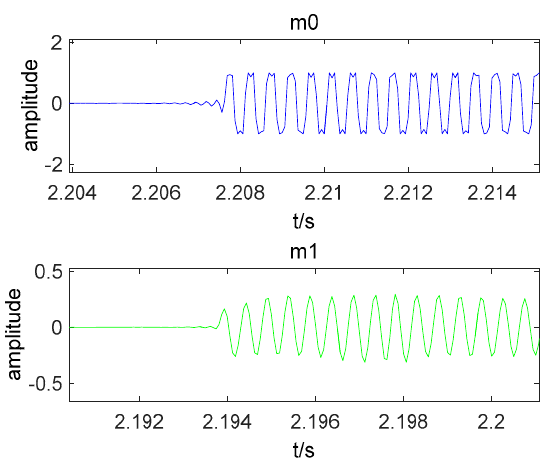
Figure 15. Partially enlarged view of the first speech segments.